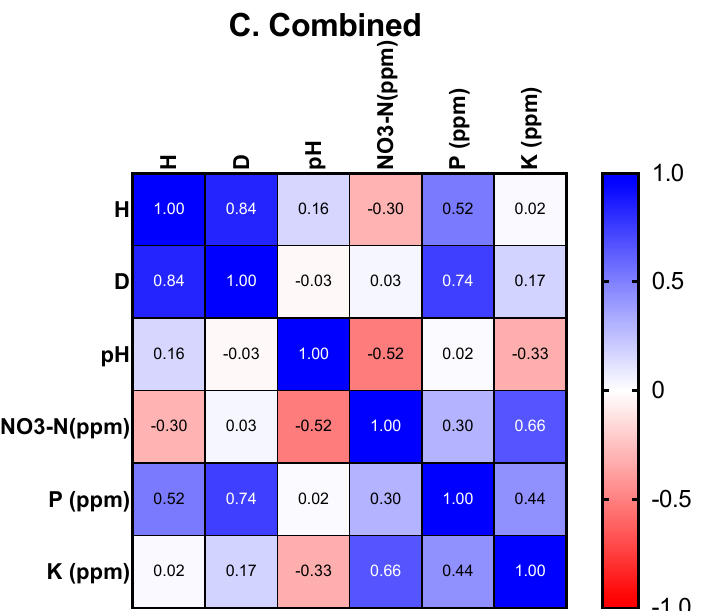
Figure 6. ( A – C ) Pearson correlation heatmaps showing the relationship between diversity indices (Shannon’s— H, Simpson’s— D) and soil parameters (pH, NO 3- N, P, and K).